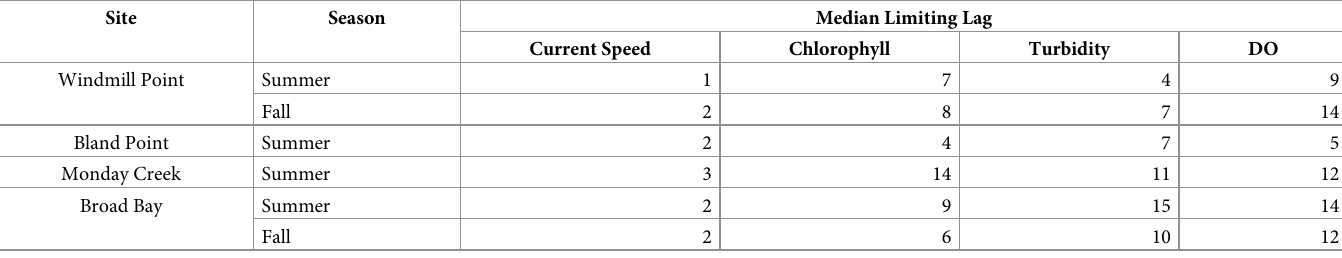
which that measurement was autocorrelated in